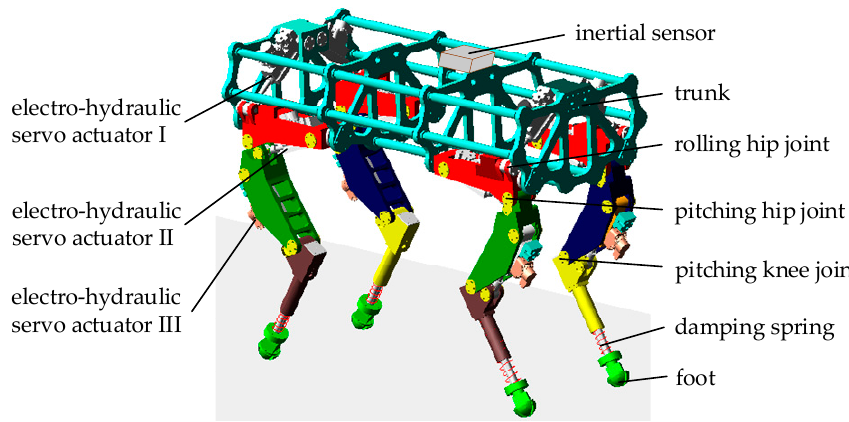
Figure 1. Model of hydraulic quadruped robot.